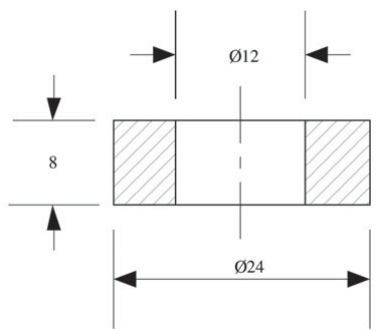
Figura 5. Dimensões do corpo de prova para o ensaio do anel.